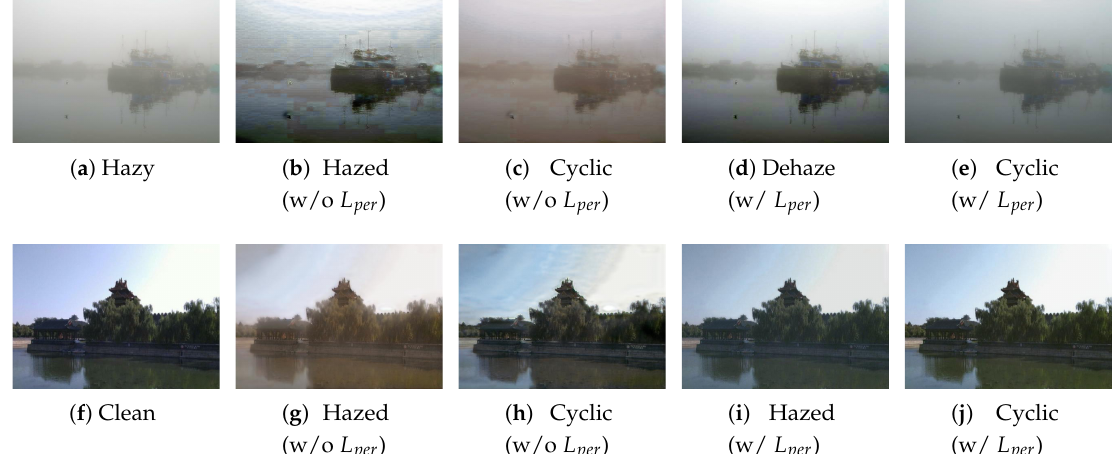
Figure 14. Comparison of dehazing with and without perceptual loss. ( a – e ) The generation direction of X → Y → X . ( f – j ) The direction of formation is Y → X → Y . “(w/o L per )” denotes the network without perceptual loss, and “(w/ L per )” denotes the network with perceptual loss. Table 7. Effect of perceptual loss in terms of SSIM, PSNR, and CIEDE2000. CycleGAN loss refers to the